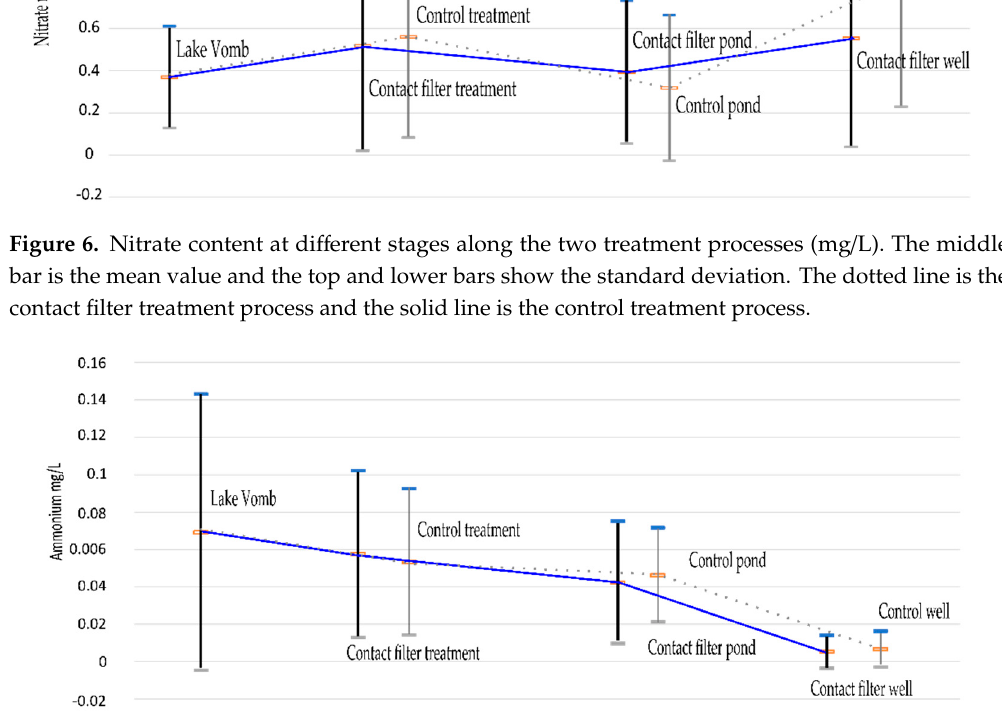
Figure 7. Ammonium content at different stages along the two treatment processes (mg/L). The middle bar is the mean value and the top and lower bars show the standard deviation. The dotted line is the contact filter treatment process and the solid line is the control treatment process.